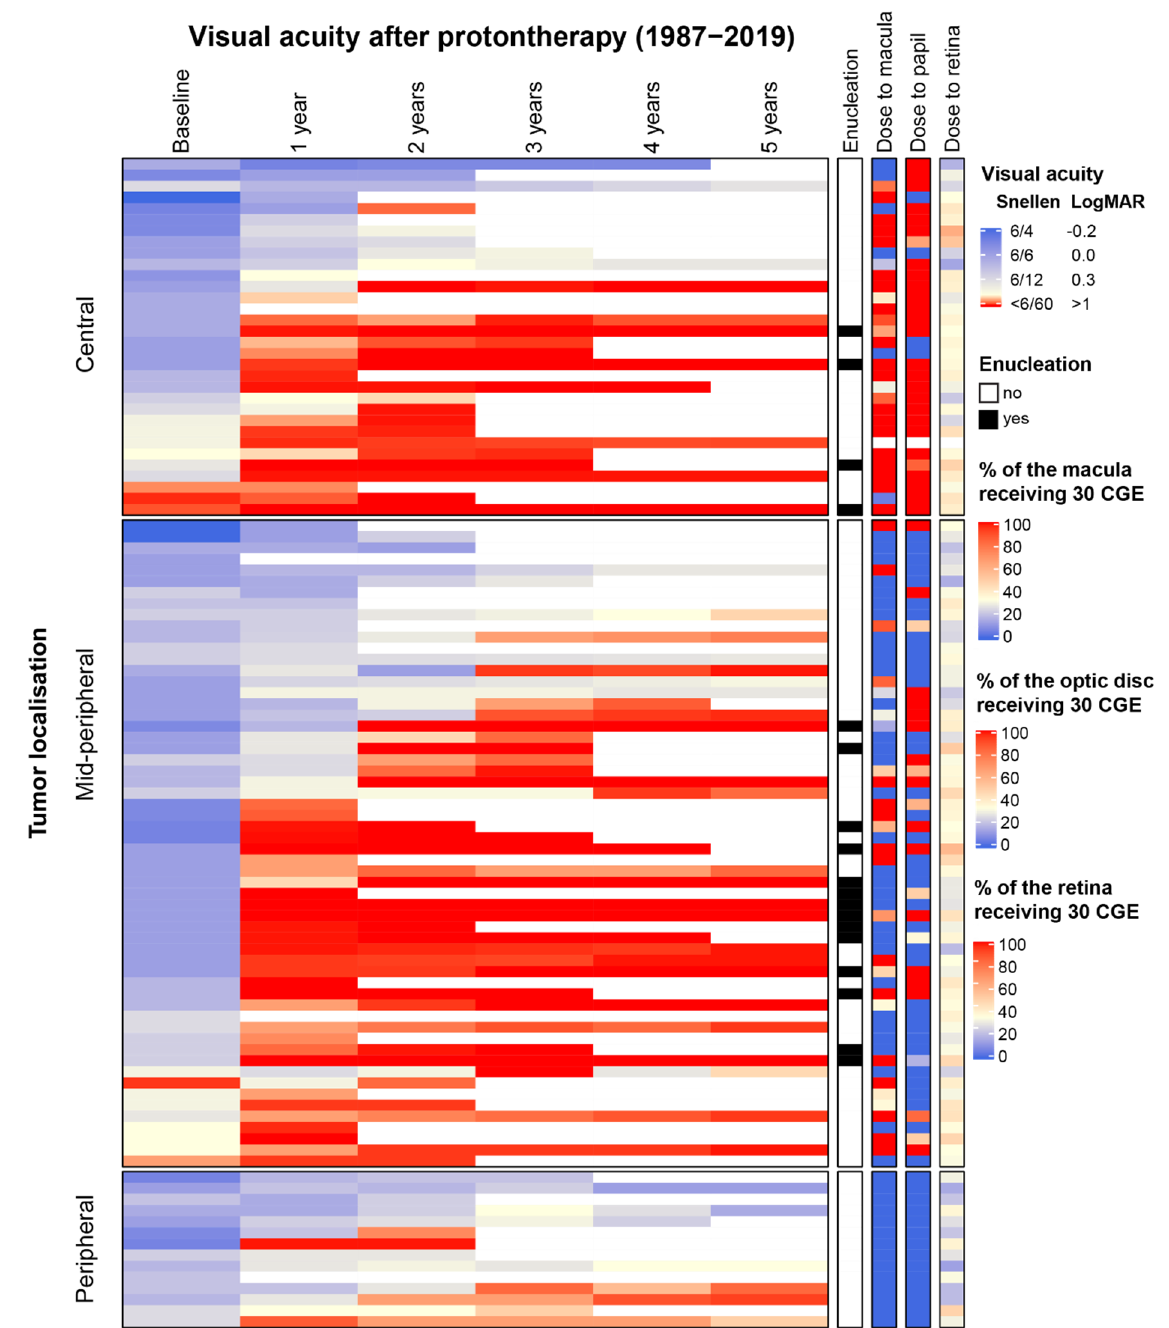
Figure 2. Relation between visual acuity after proton therapy and dose parameters by tumour localisation. Each hori- zontal row in the heat map represents an eye. The total number included eyes in this analysis is 103. Data is clustered on visual acuity during follow-up by tumour localisation. The four non-clustering annotations bars at the right side of the heat map display the values for each eye for enucleations in the first 5 years and three dose parameters. This graph gives on overview of the pattern of decline in visual acuity across follow-up in the cohort and shows the relation between visual impairment and relevant clinical and radiotherapeutic factors at the individual level.